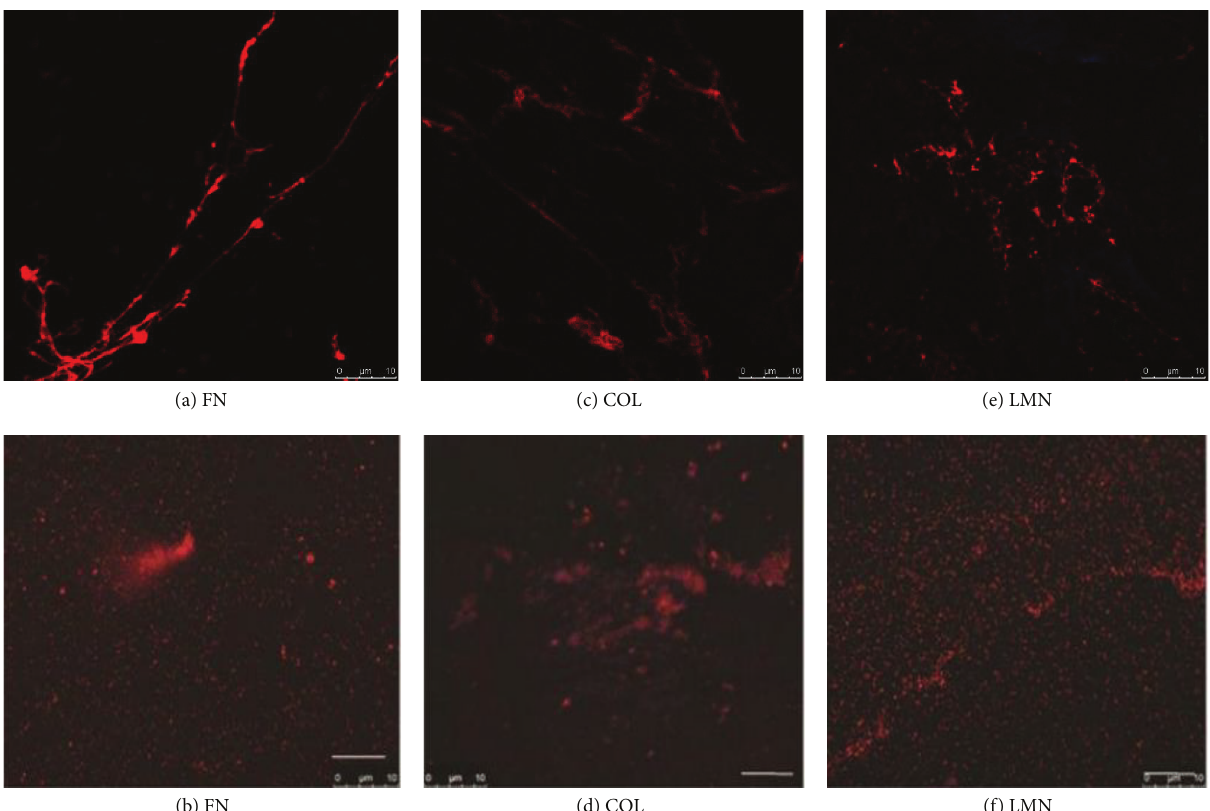
Figure 7: Characterization of native and spin coated ACM by immunostaining (“(a), (c), and (e)” indicate native ACM and “(b), (d), and (f)” indicate spin coated ACM). (a) and (b) Immunostaining of fibronectin, (c) and (d) immunostaining of collagen, and (e) and (f) immunostaining of laminin (scale bar: 10 𝜇